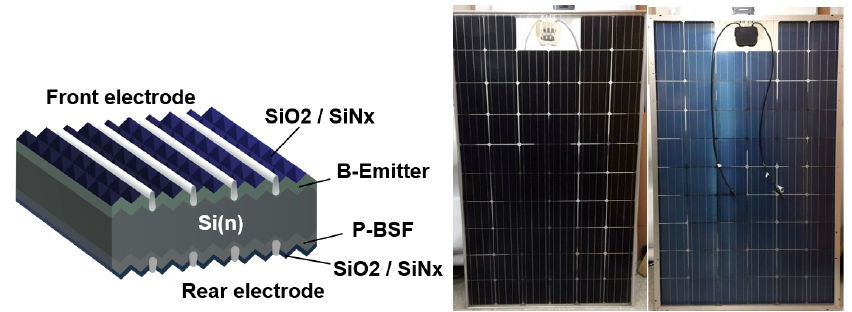
Figure 1. n-PERC Cell Structure and Module used in the experiment. PERC: The passivated emitter and rear contact. P-BSF: Phosphorus Back Surface Field. B-Emitter: Boron Emitter.